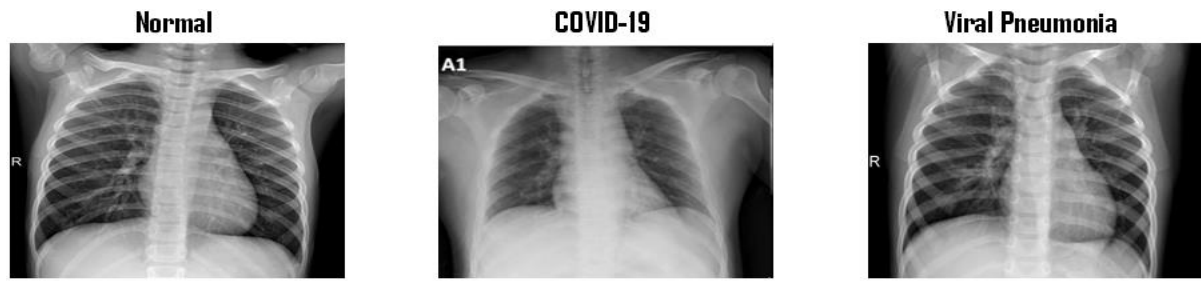
Figure 1. Illustrative examples of Chest X-ray samples from COVID-19 radiography database.